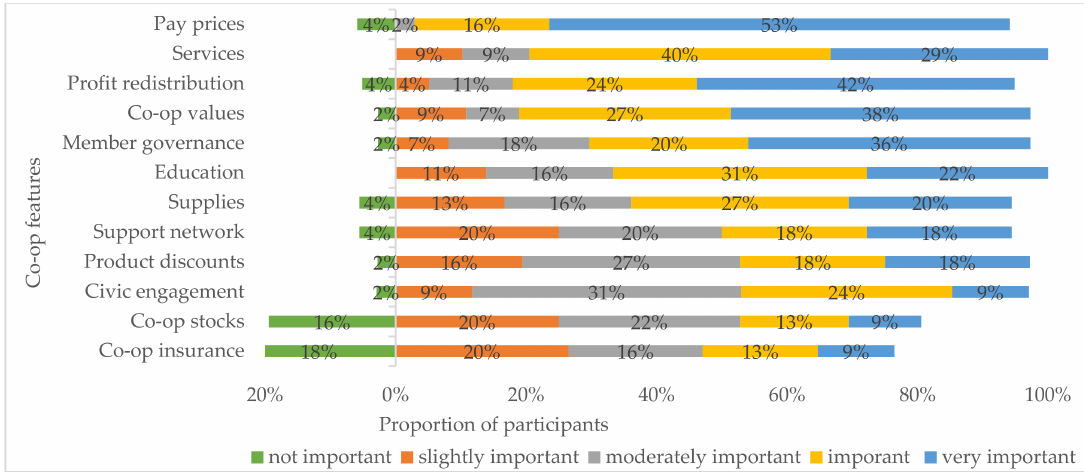
Figure 1. The levels of importance of co-op features from participant